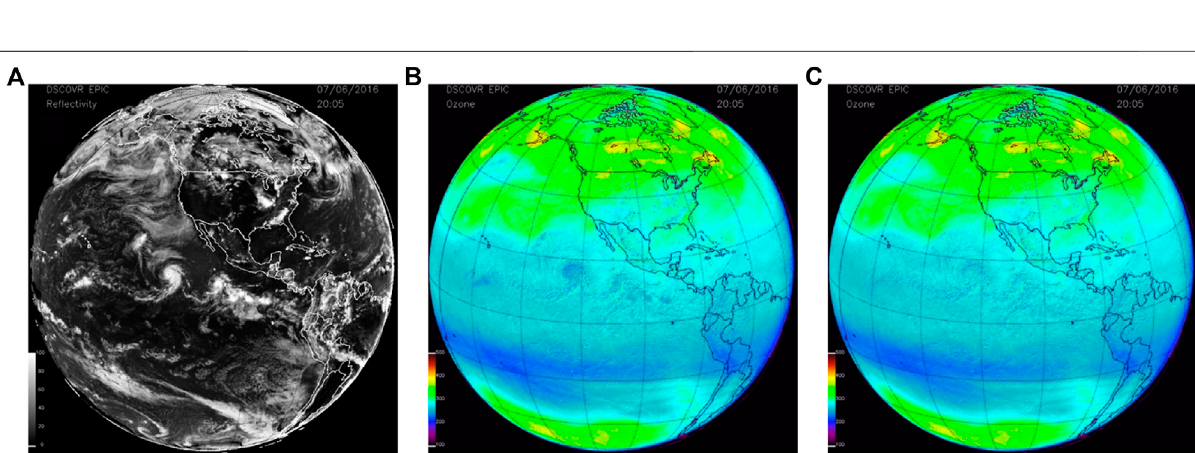
Frontiers in Remote Sensing |